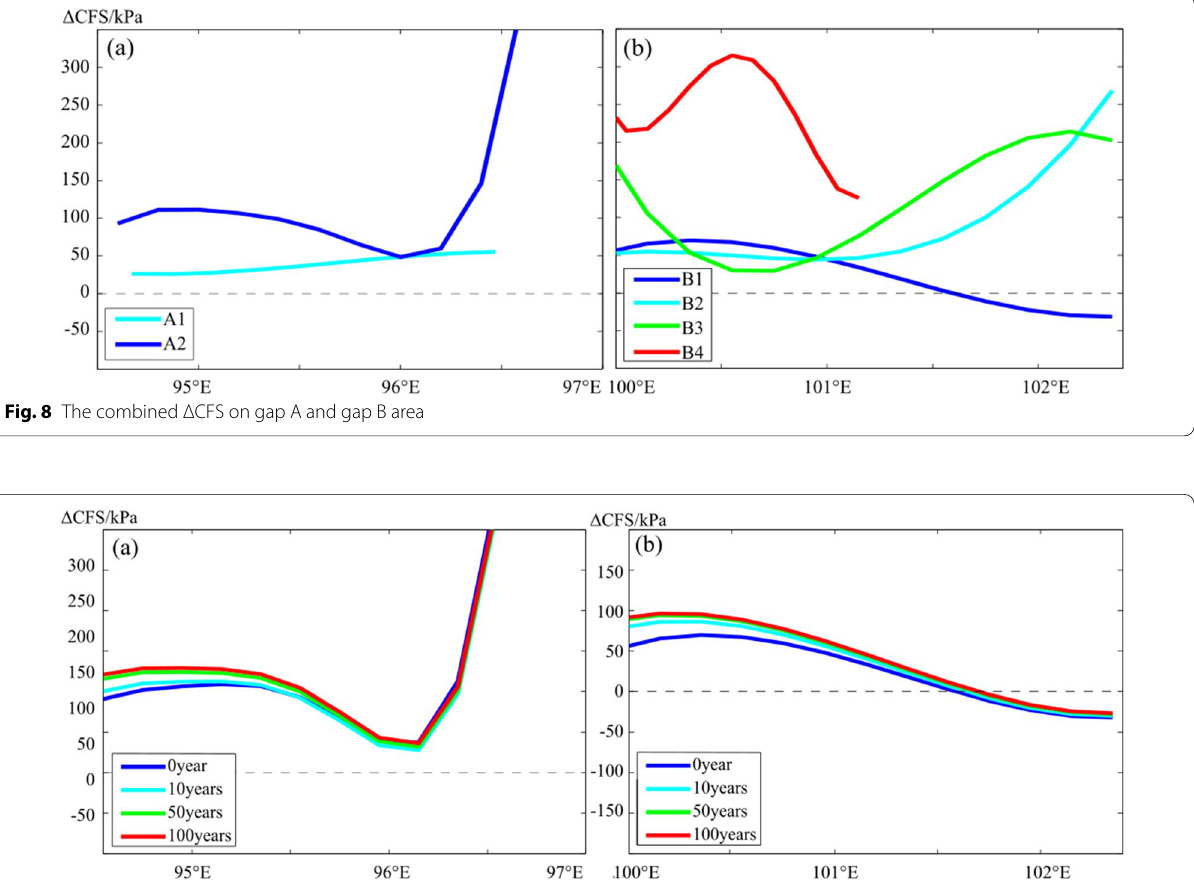
Fig. 9 ΔCFS on A1 and B1 at time intervals of 0, 10, 50, and 100 years after